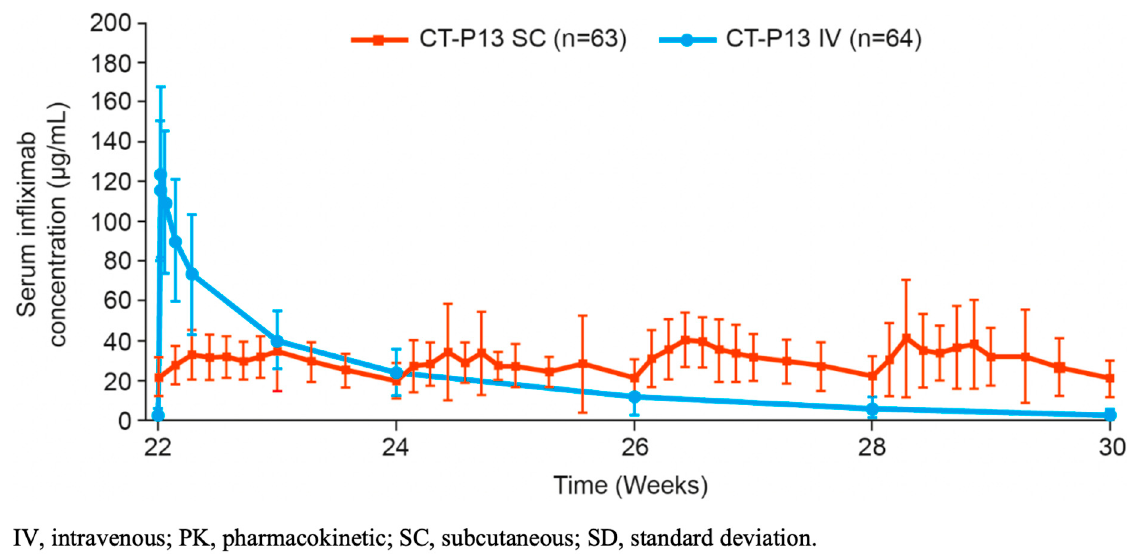
Figure 3. Mean ( ± SD) serum infliximab concentration for CT-P13 subcutaneous and CT-P13 intra- venous arms during the more intensive 8-week sampling interval at steady state (PK monitoring period; PK population). Reprinted from: Gastroenterology, 2021; Schreiber S. et al. Randomized Controlled Trial: Subcutaneous vs. Intravenous Infliximab CT-P13 Maintenance in Inflammatory Bowel Disease (online Supplementary Materials, Figure S7, p. 31), Copyright (2021), with permission from Elsevier.